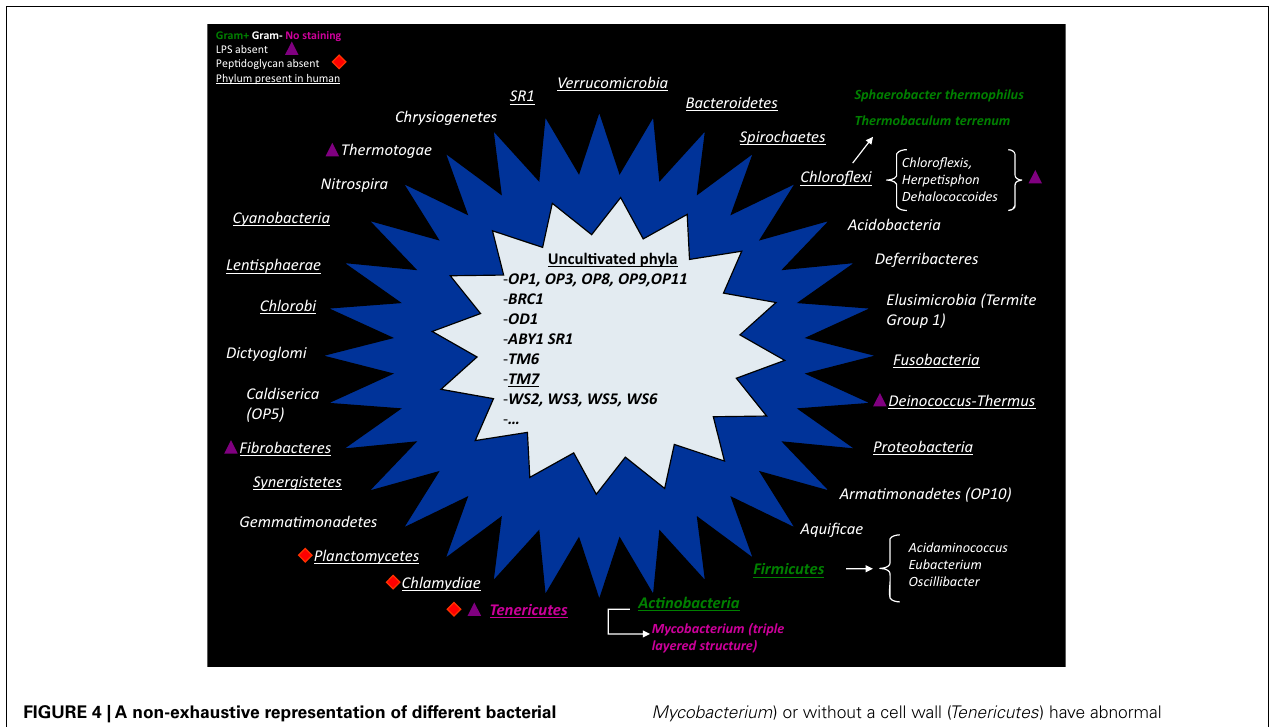
FIGURE 4 |A non-exhaustive representation of different bacterial phyla found in culture (outer star in blue) or phyla with no representative in culture (inner star in gray). Gram-positive bacteria are colored in green, and Gram-negative bacteria are colored in white. Bacteria with an atypical cell wall (triple-layered structure of